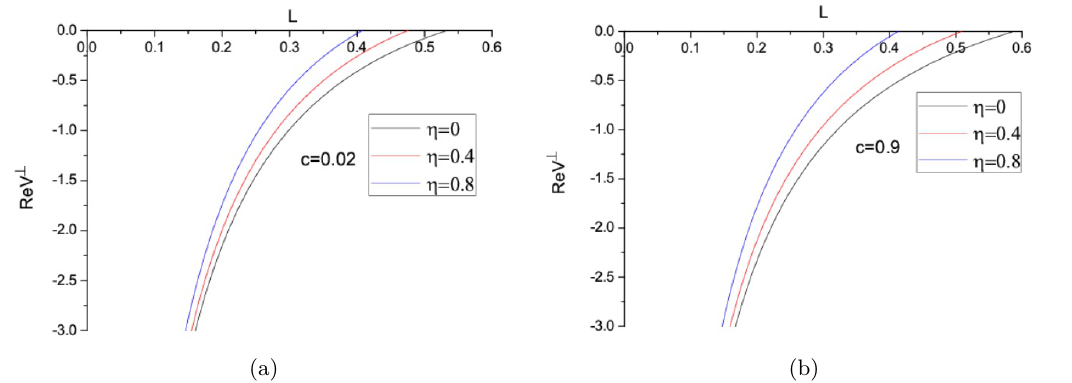
Figure 1 . Re V as a function of L for a Q ¯ Q pair oriented transverse to the axis of the quarks, Q ¯ Q from top to bottom for η = 0 . 8 , 0 . 4 , 0 respectively, T = 200 MeV , in the presence of GC, for a) c = 0 . 02 Ge V 4 and b) c = 0 . 9 Ge V 4